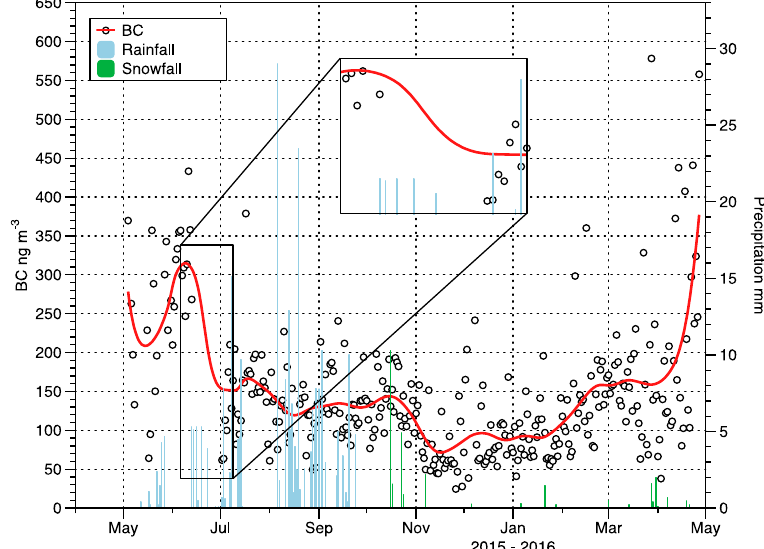
Figure 5. The variation of daily-averaged BC and rainfall during the study period, where the red line is the LOESS fit of the BC. The magnified frame shows the typical suppressing effect of precipitation on the concentrations of BC.